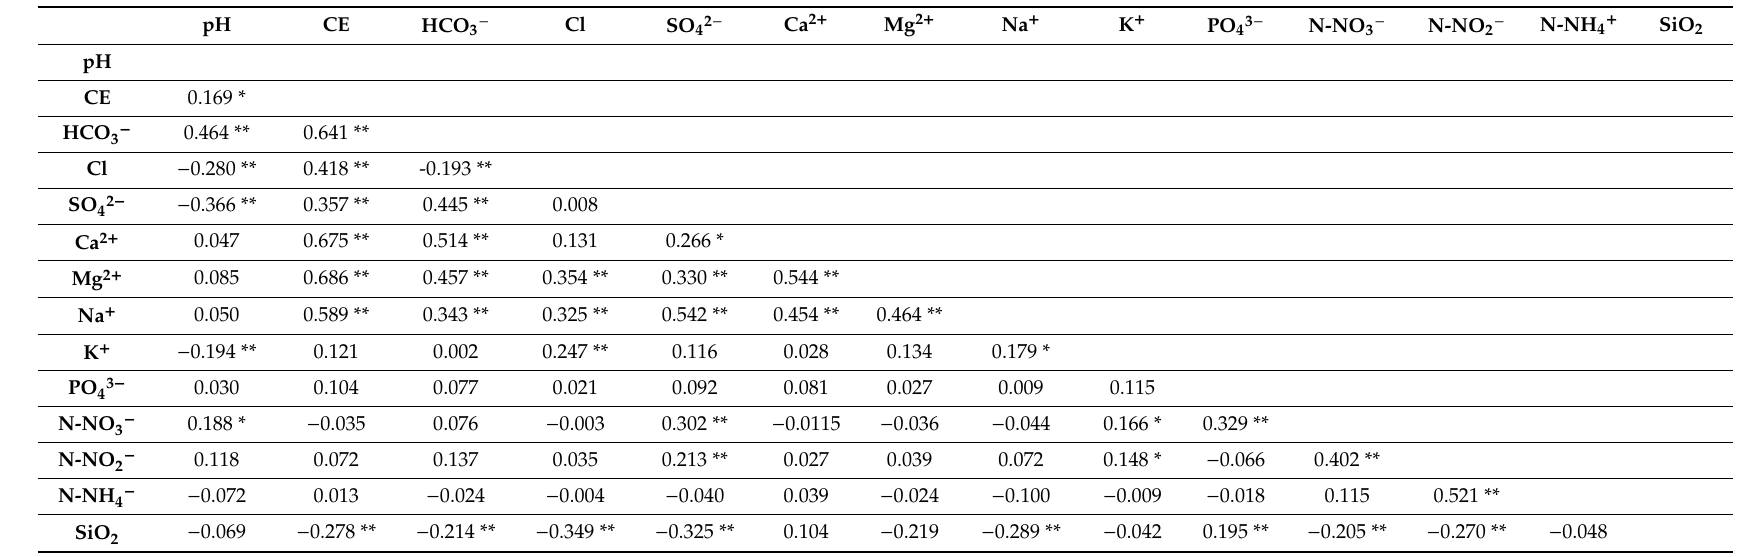
Table 3. Spearman Correlations between pH and electrical conductivity (EC) and a set of relevant elements of water ( p < 0.05 *; p < 0.01